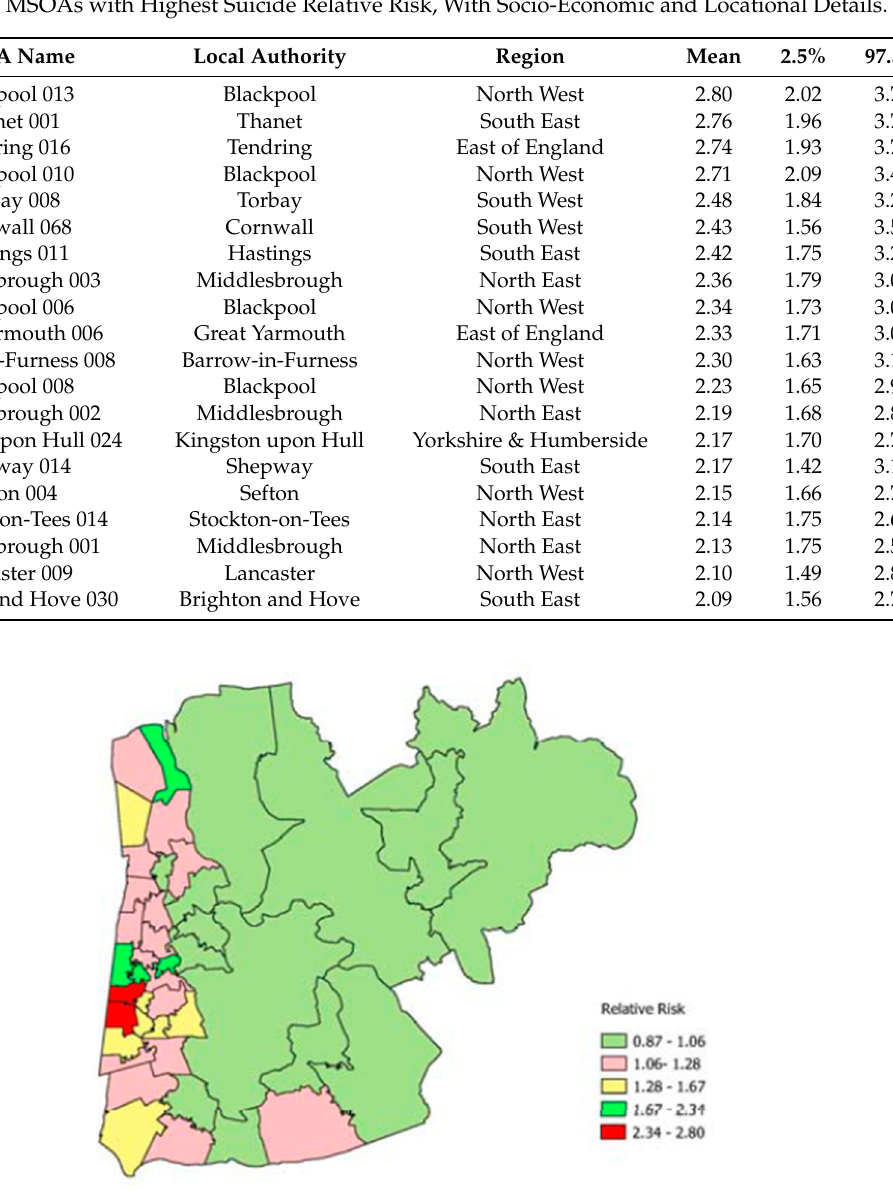
Figure 5. Suicide risk by MSOA (Blackpool, Fylde, Wyre).